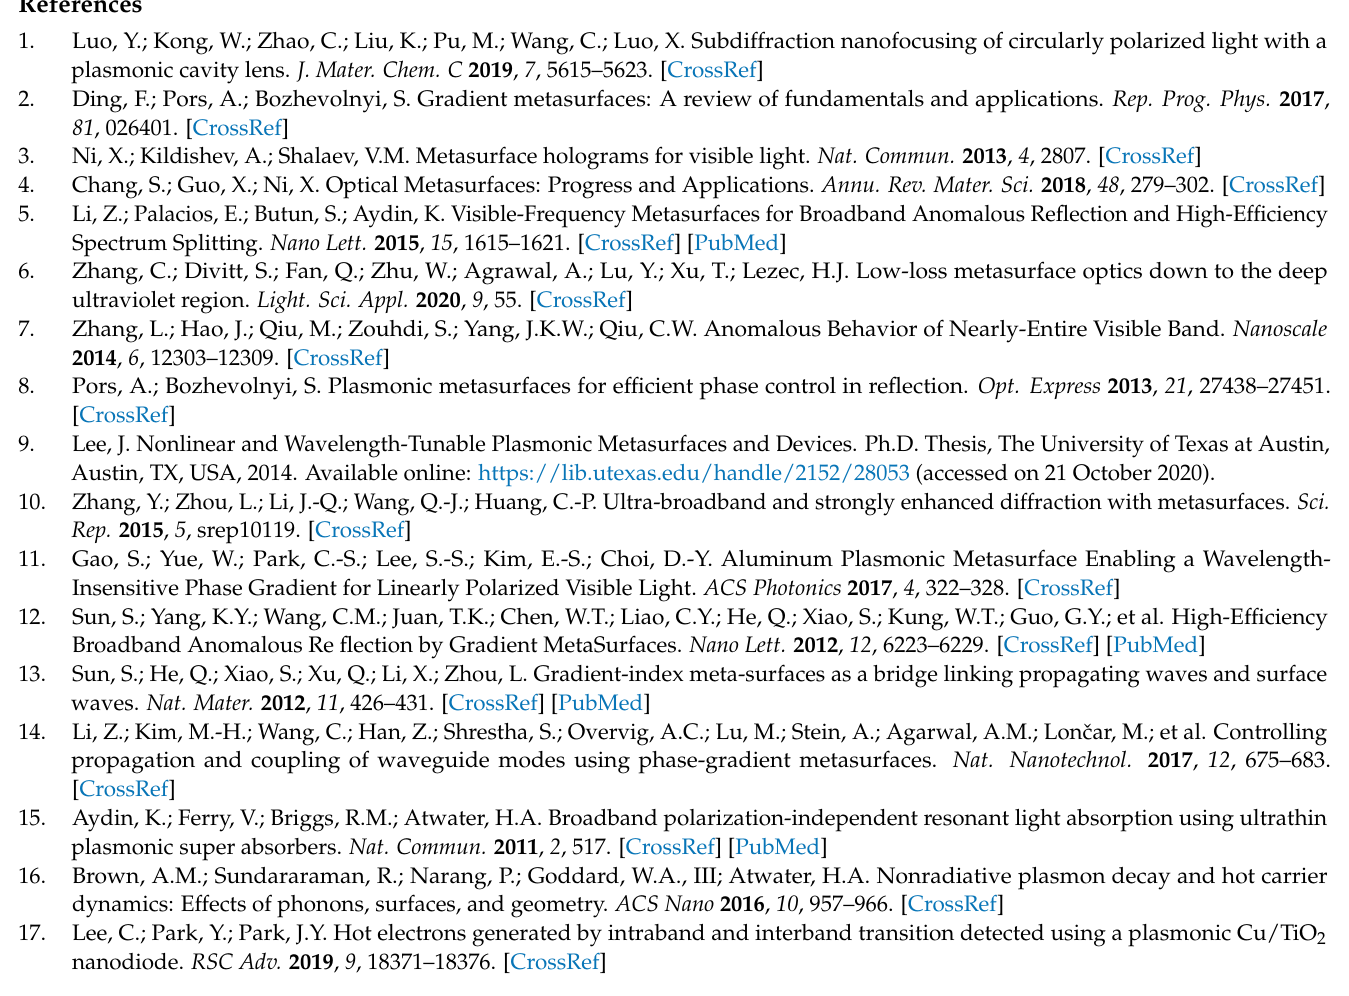
total broadband anomalous beam steering efficiency, Figure S1.2: Different length trapezoid’s angle- resolved wavelength dependent far-field electric field and the reflection efficiencies at different orders, Figure S2.1: Dispersion for SiO 2 /Cu and air/Cu interface, the calculated K SPP and the theoretical SPP propagation length vs. incidence wavelength, Figure S2.2: Simulated E and Ez field at the tip to base cross-section for the trapezoids and rectangles in a row, Figure S2.3: Simulated wavelength-dependent E and Ez field in a particular x-position of the trapezoid and the rectangle, Figure S3: SPP channeling with Cu-bottom layer thickness variation, Video S1: Ez component from the three 550L trapezoids, Video S2: Ez component from the three 550L rectangles, Video S3: Long-range SPP wave propagation from the four 550L trapezoids, Video S4: Ez component of the long-range SPP wave propagation for the four 550L trapezoids, Video S5: Long-range SPP wave propagation from the four 550L rectangles, Video S6: Long-range SPP wave propagation from the three 918L trapezoids, Video S7: Ez component of long-range SPP wave propagation from the three 918L trapezoids, Video S8: Long-range SPP wave propagation from the three 918L